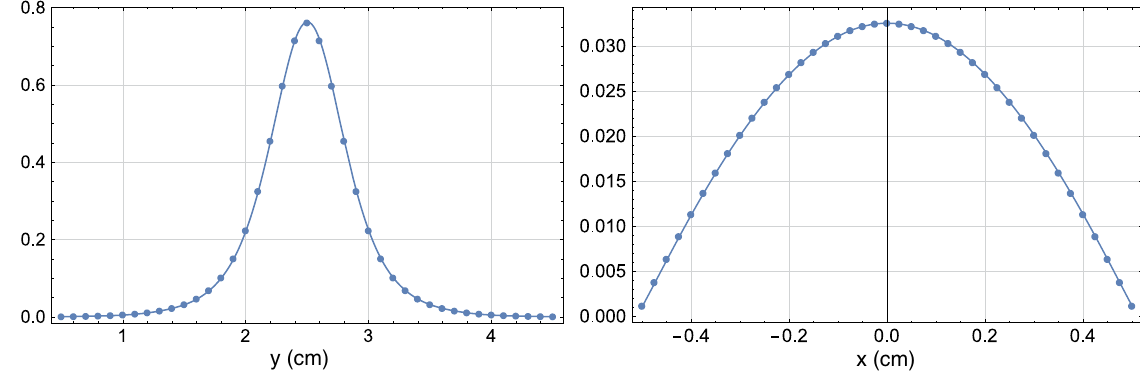
FIG. 3. Y-dependence (left) and X-dependence (right) of E normalized by − 2 Q=a 2 × π 2 = 8 in the case where the test charge is located z at x ¼ 0 . 4 cm from the center for the y-plot (left) and y ¼ 3 . 8 cm for the x-plot (right). Points are computed using the mode decomposition method [14] (array of 5 by 500 modes were taken into account) and solid lines are obtained from